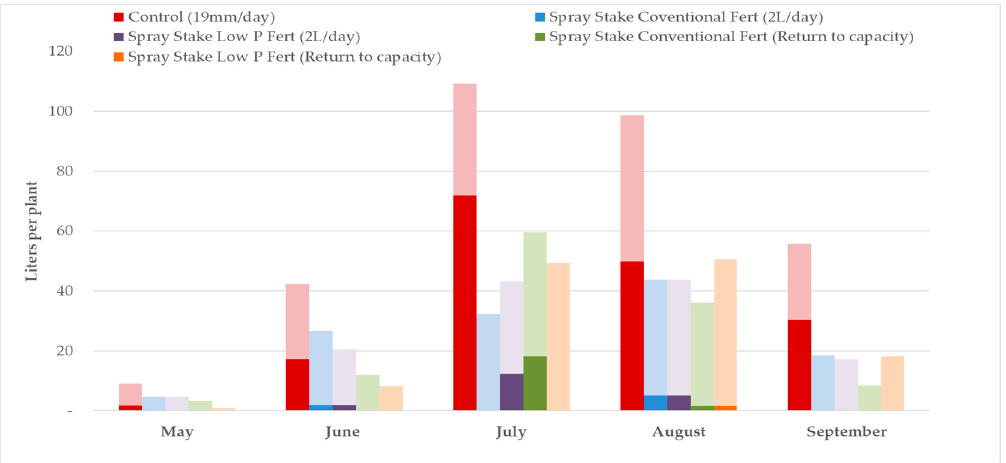
Figure 3. The relative contributions of water scarcity footprint from water dilution requirement (WSF wd ) from runoff and infiltration water on per-plant monthly WSF wd of woody plants grown in 10.2 L containers for data collected May through September 2017, under five irrigation regimens in a model research nursery in Michigan. For each color, darker shade is runoff and lighter shade is infiltration.